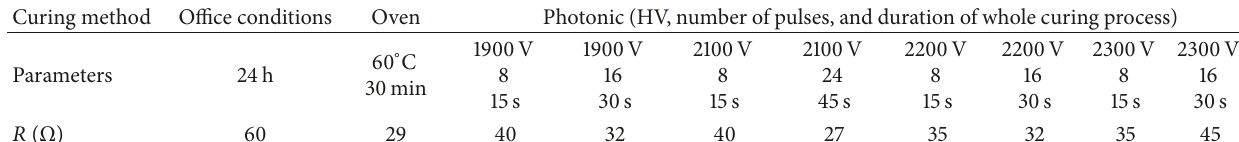
Table 1: Resistance of a printed graphene line on cardboard with different curing parameters.